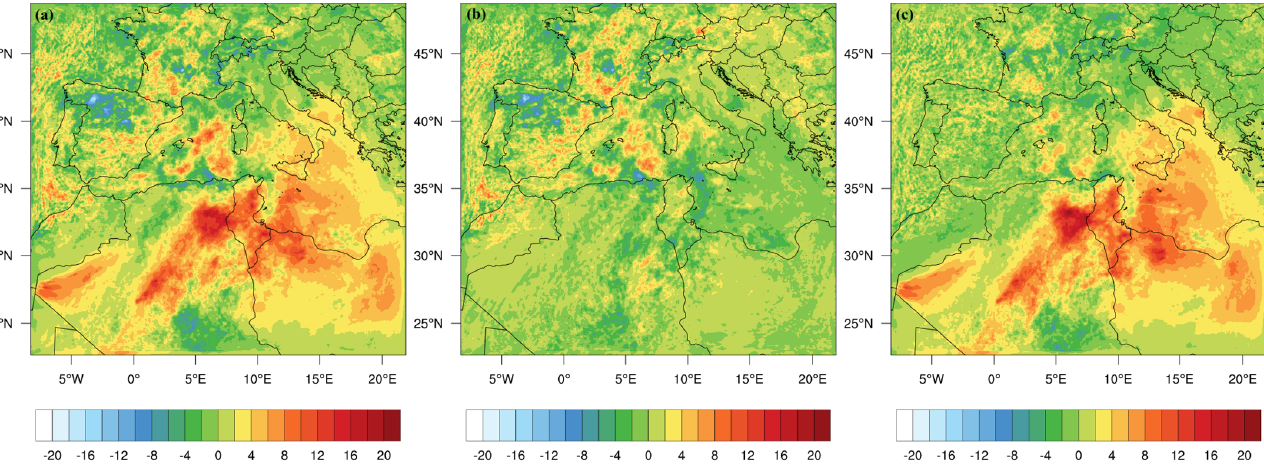
Figure 12. Simulated surface longwave downwelling flux (SLWDN) anomalies; ( a ) FULL − CTL runs difference; ( b ) MP − CTL runs difference and ( c ) RAD − CTL runs difference. Units are W m − 2 .